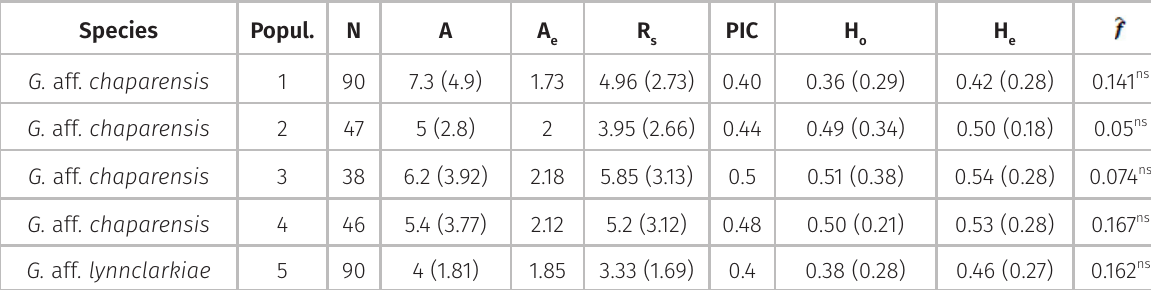
Table V. Genetic diversity of populations of Guadua aff. chaparensis and G. aff. lynnclarkiae evaluated in the municipalities of Sena Madureira, AC and Porto Acre,